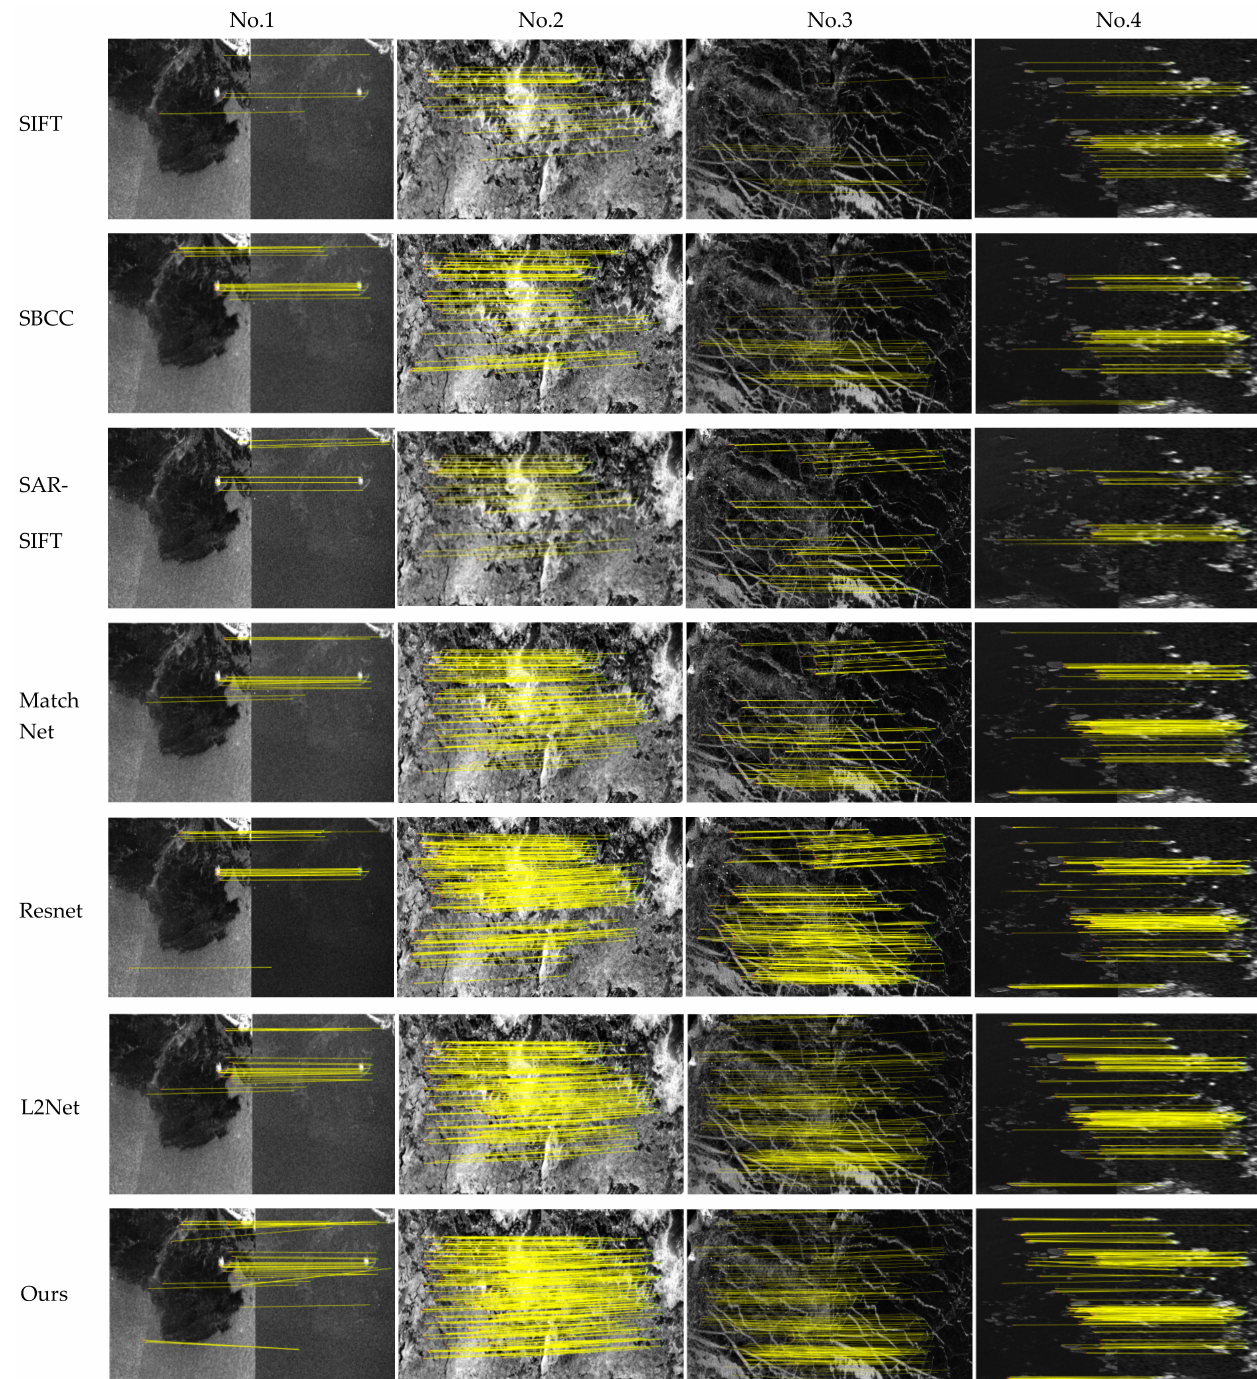
Figure 10. The correct matching results of sea ice images with the same polarization